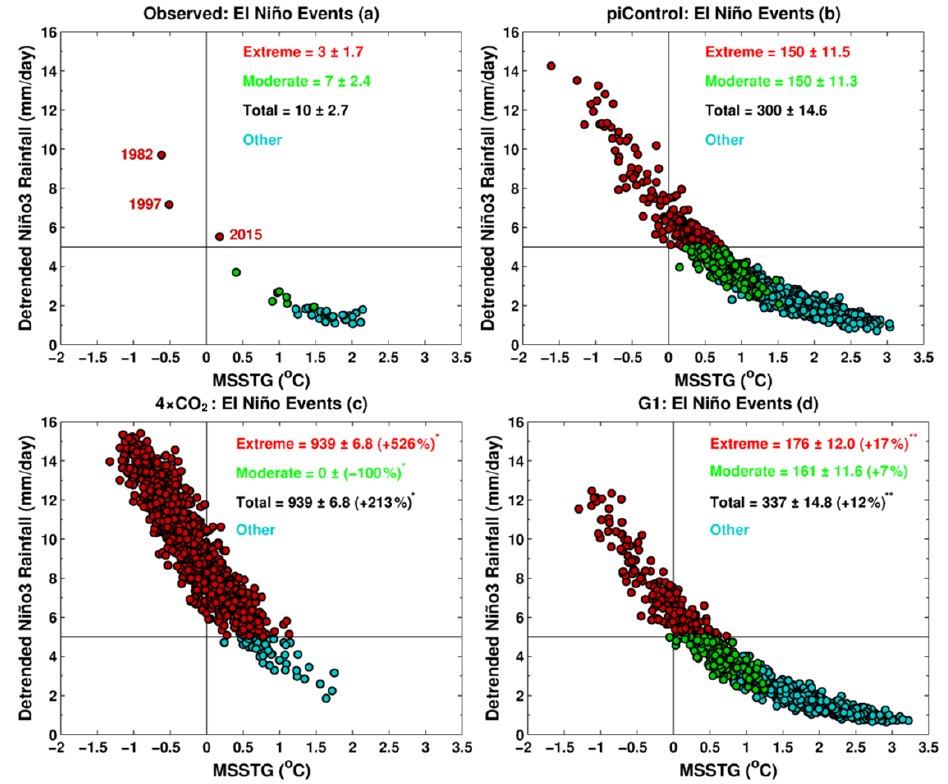
Figure 7. Relationship between MSSTG and Niño3 rainfall for (a) observations, (b) piControl, (c) 4 × CO 2 , , and (d) G1. A horizontal solid black line indicates a threshold value of 5mmd − 1 . See text for the definition of extreme, moderate, and total El Niño events. A single (double) asterisk indicates that the change in frequency, relative to piControl, is statistically significant at 99% (95%) cl. Numbers with a ± symbol indicate SD calculated with 10000 bootstrap realizations. Following Cai et al. (2014), a non-ENSO-related trend has been removed from the rainfall time